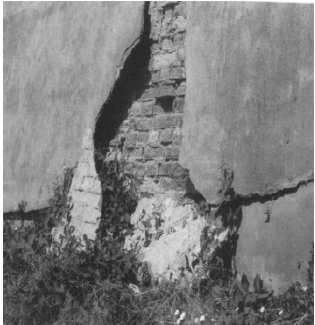
Fig. 9. Delamination of the eastern retaining wall lining